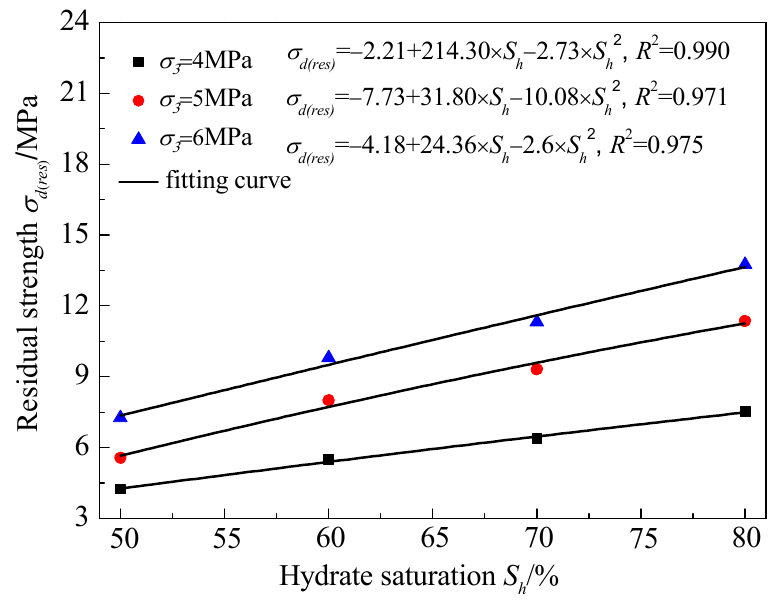
Figure 10. Variation of the residual strength with the hydrate saturation.